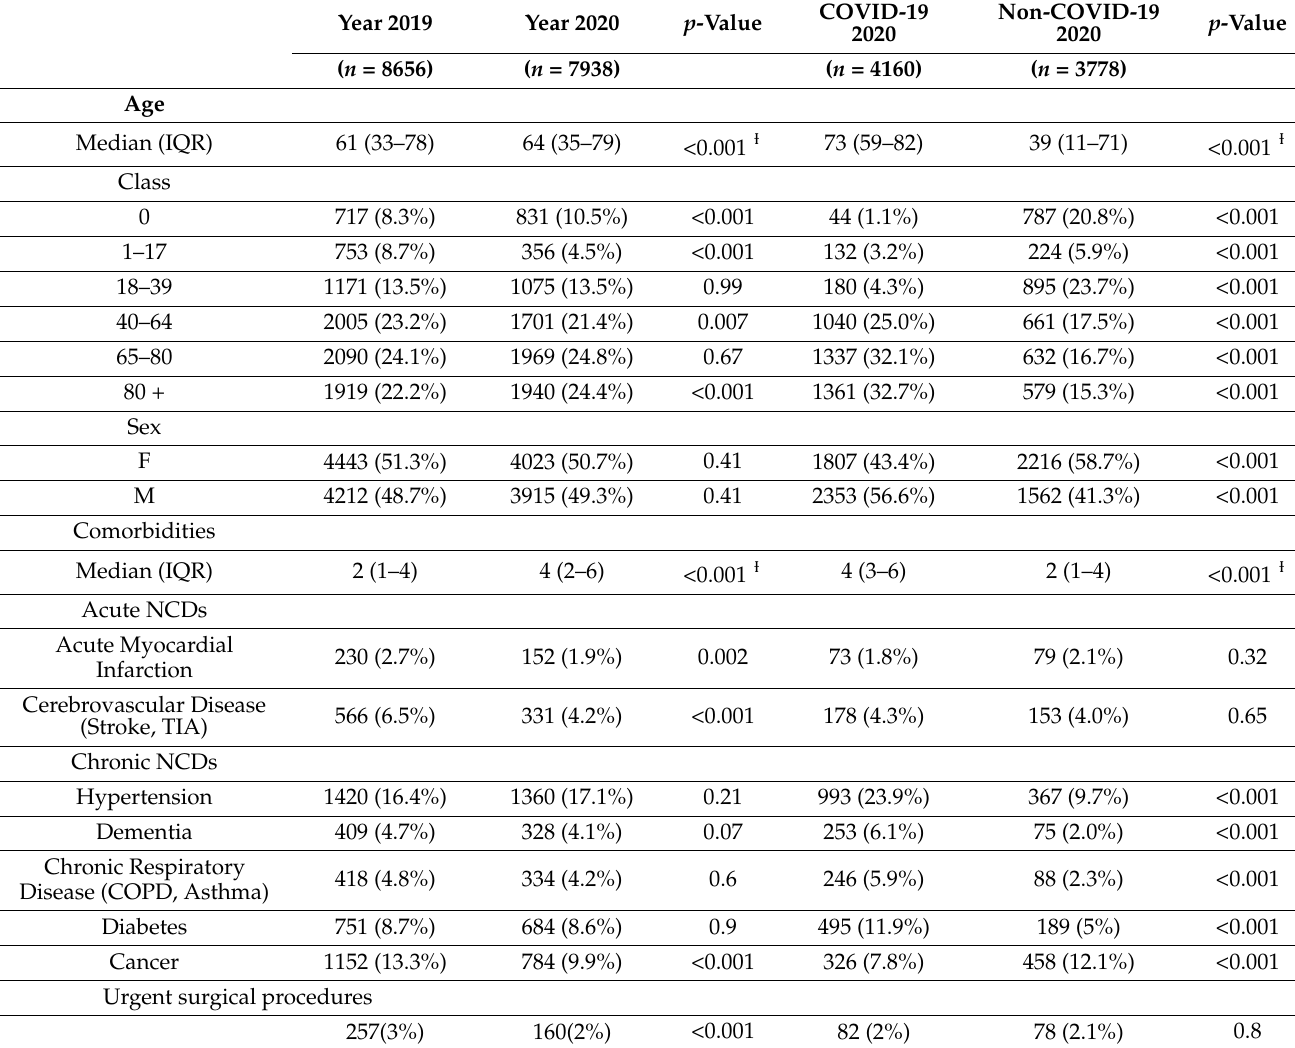
Table 1. Baseline characteristics of hospitalized patients between 23 February and 14 May.